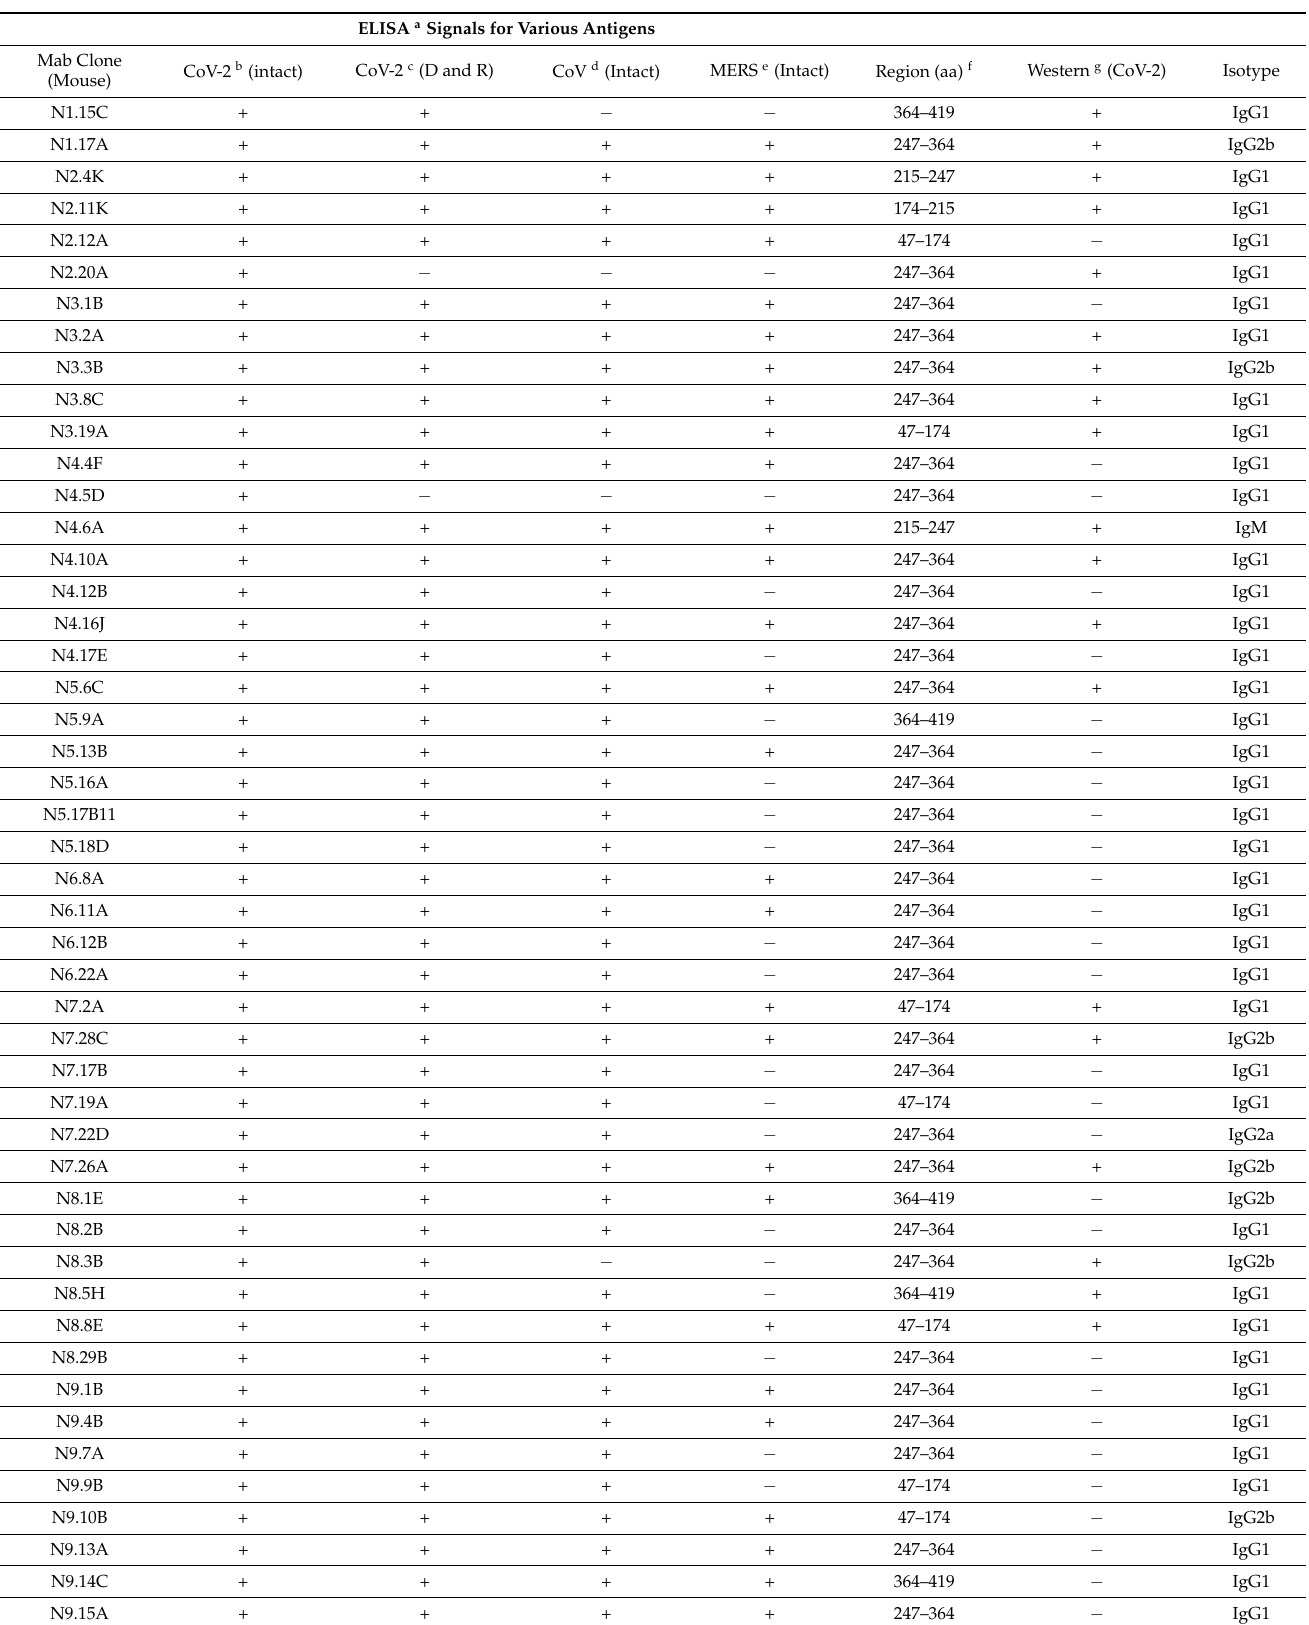
Table 3. mAbs against CoV-2 N